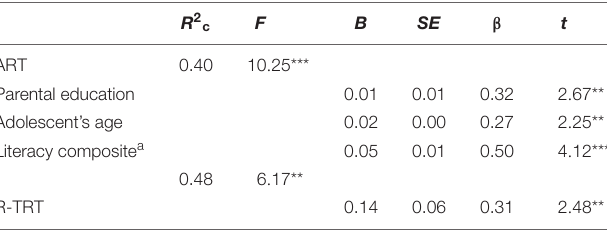
TABLE 3 | Hierarchical multiple regression analysis estimating associations with the